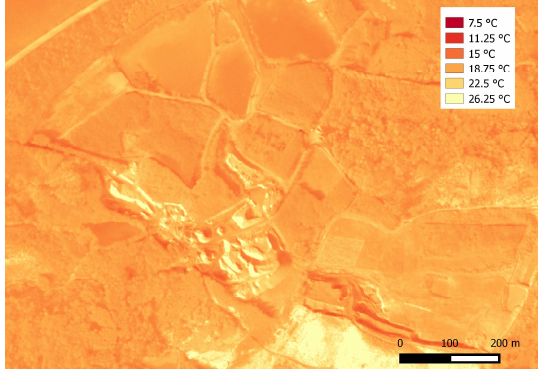
Figure 11. Magnification of the TIR image to show the stone pit in more